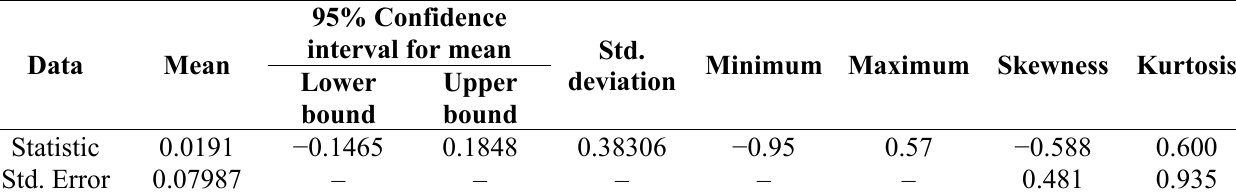
Table 1. Descriptive statistics for log-return.